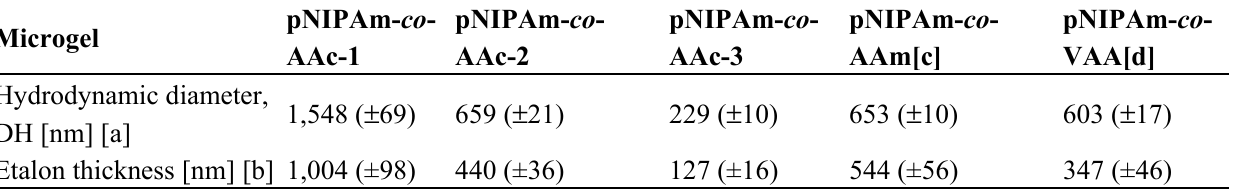
Table 1. Physical properties of